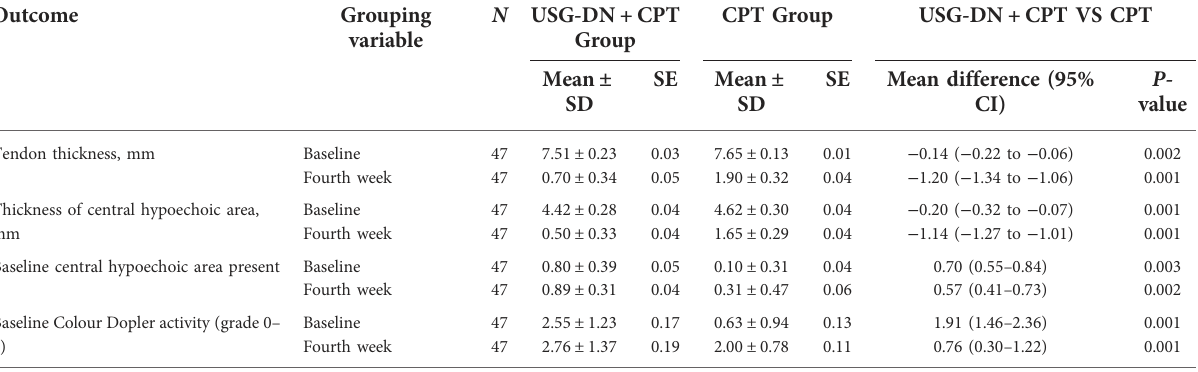
TABLE 4 Results of ultrasonographic examination.